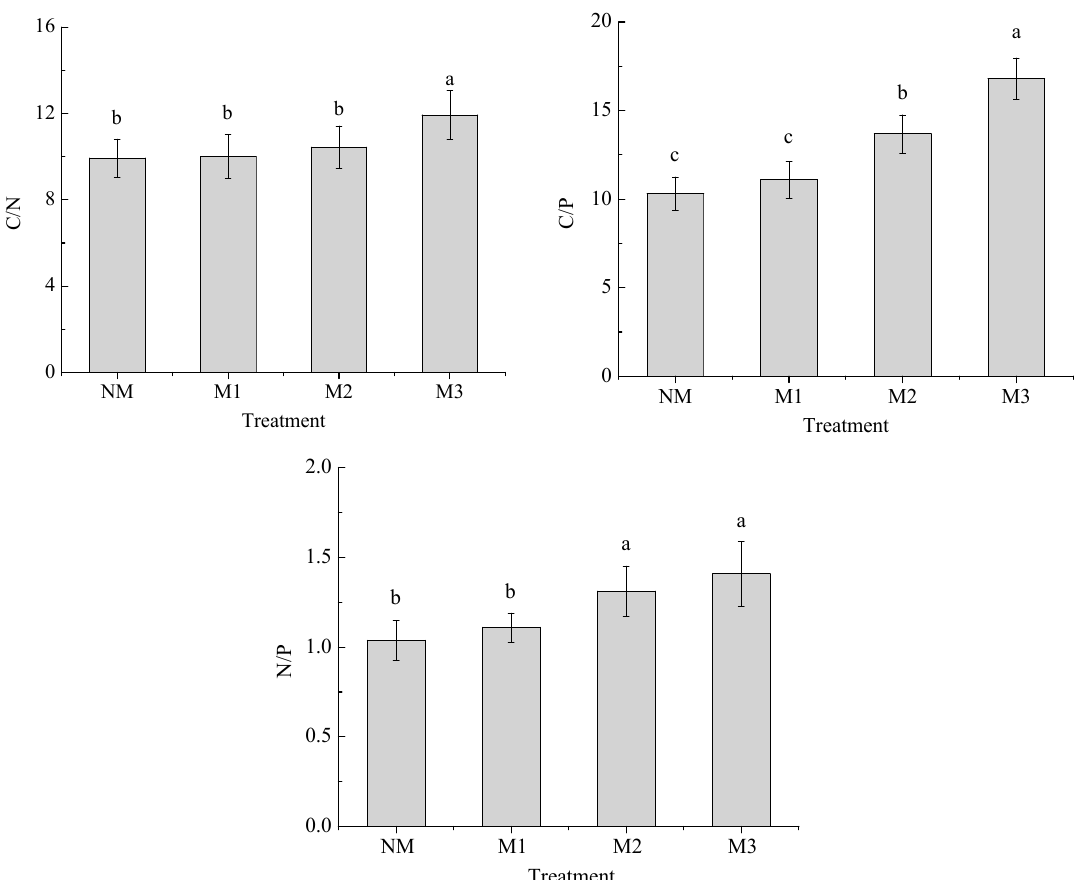
Figure 2. Stoichiometry of the nutrients of soil in P. edulis stands of different mulching years. The bars mean the standard error ( n = 9). Different lowercase letters in the figure indicate significant differences among different treatments at the p < 0.05 level. NM, M1, M2 and M3 represent no-mulching, mulching for one year, two years and three years, respectively.